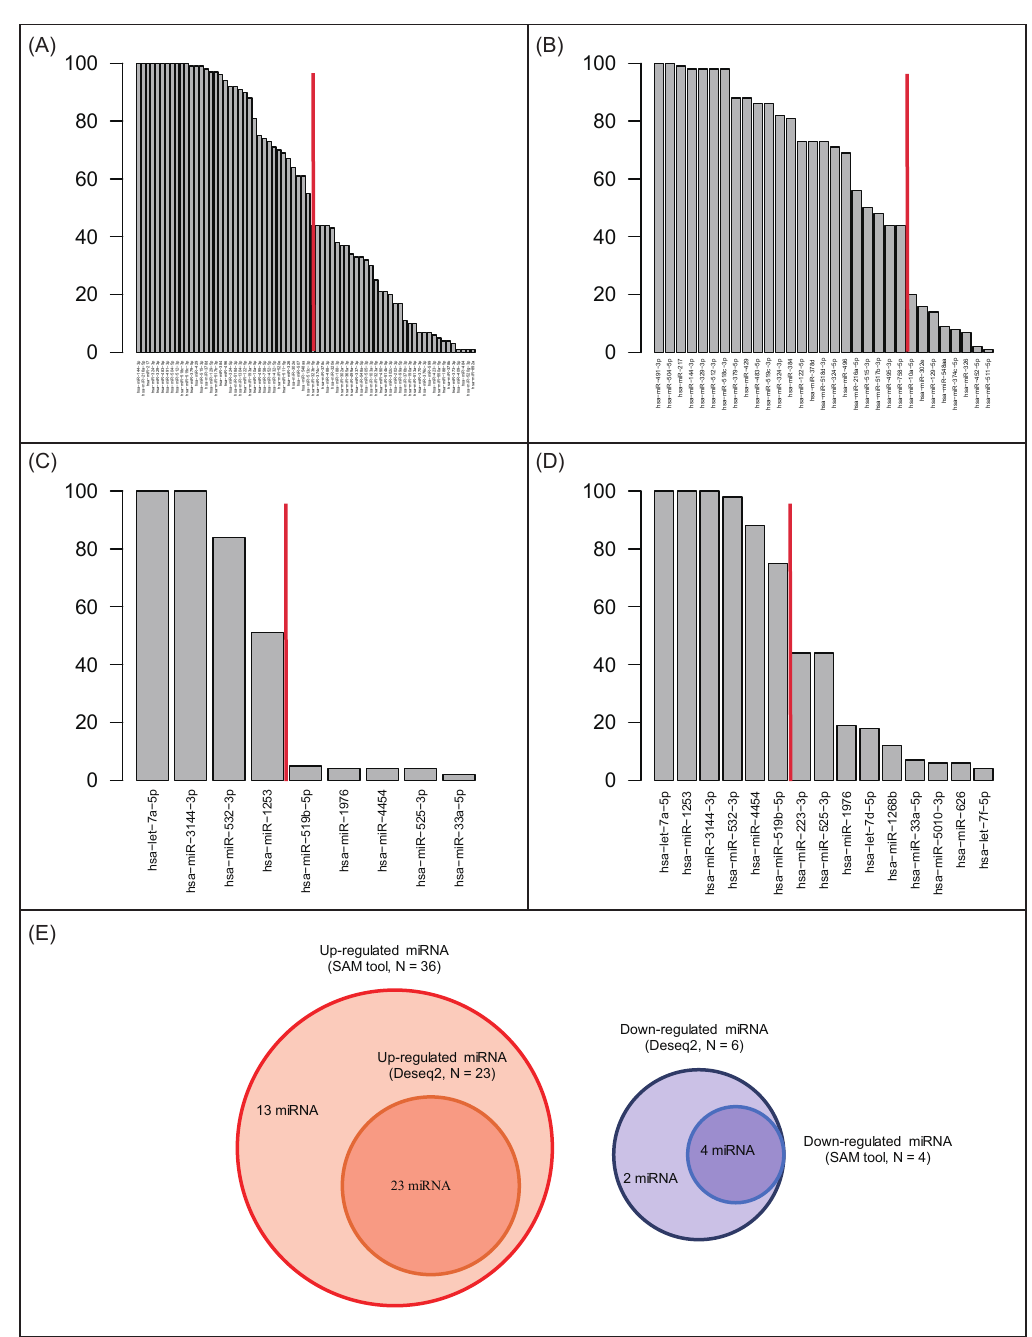
Figure 3. Differentially regulated miRNAs after MD identified using SAM and DESeq2. ( A ) Up-regulated miRNAs identified using SAM. ( B ) Up-regulated miRNAs identified using DESeq2. ( C ) Down-regulated miRNA identified using SAM. ( D ) Down-regulated miRNAs identified using DESeq2. ( E ) Numbers of miRNAs selected using both SAM and